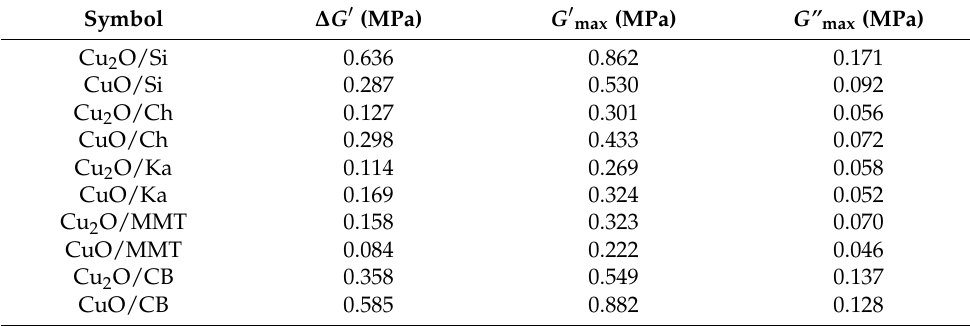
Table 5. Payne effect of filled CR vulcanizates; T = 160 ◦ C, t = 45 min.